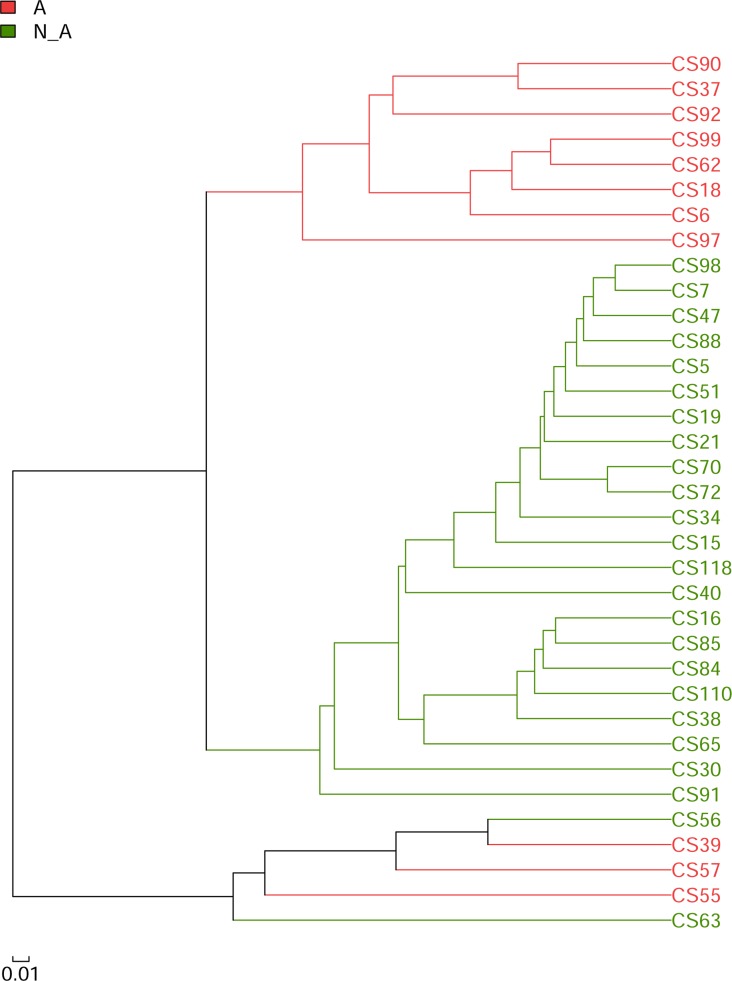
Hierarchical cluster tree.Anaplasma-positive and Anaplasma-negative samples were hierarchically clustered using UPGMA algorithm based on Bray-Curtis distances. A: Anaplasma-positive, in red; N_A: Anaplasma-negative, in green.